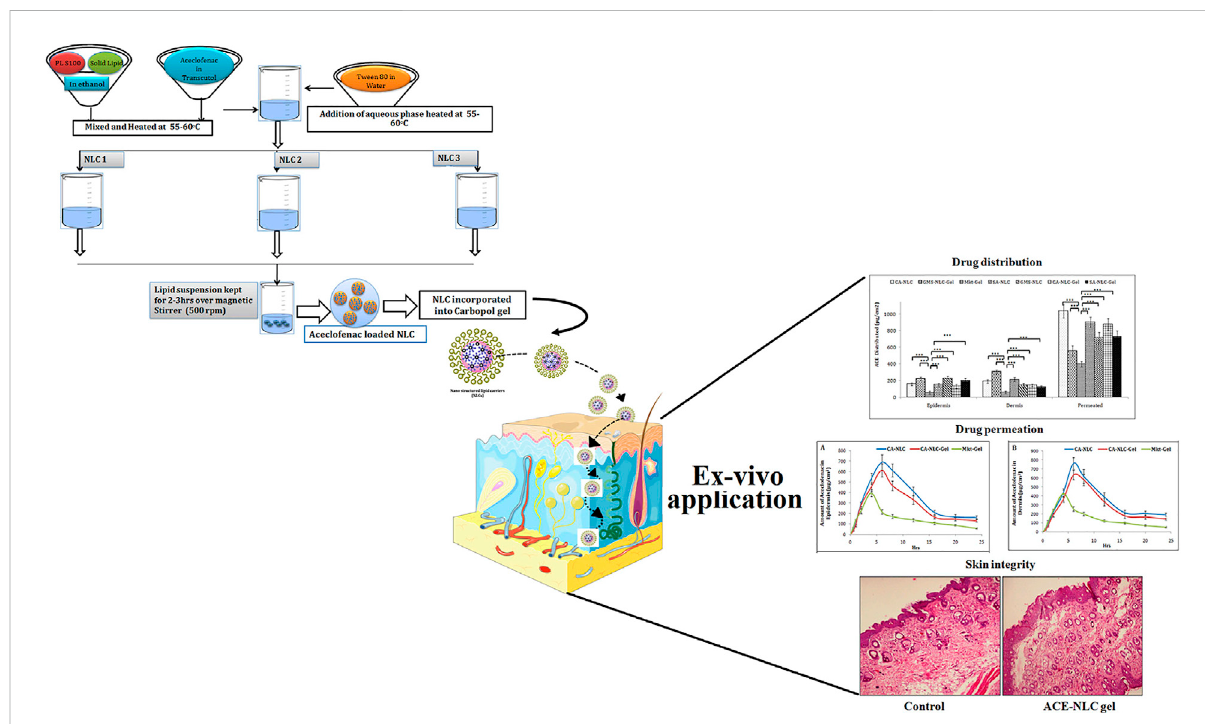
FIGURE 2 SchematicpresentationofsynthesisofNLCswiththreedifferentmethodstoproduceACE-NLC-gel andtheresultsoftransdermalapplications against in fl ammatory disorders in animal models. Reproduced with permission from Garg et al., Original Research; published by Frontiers in Pharmacology,